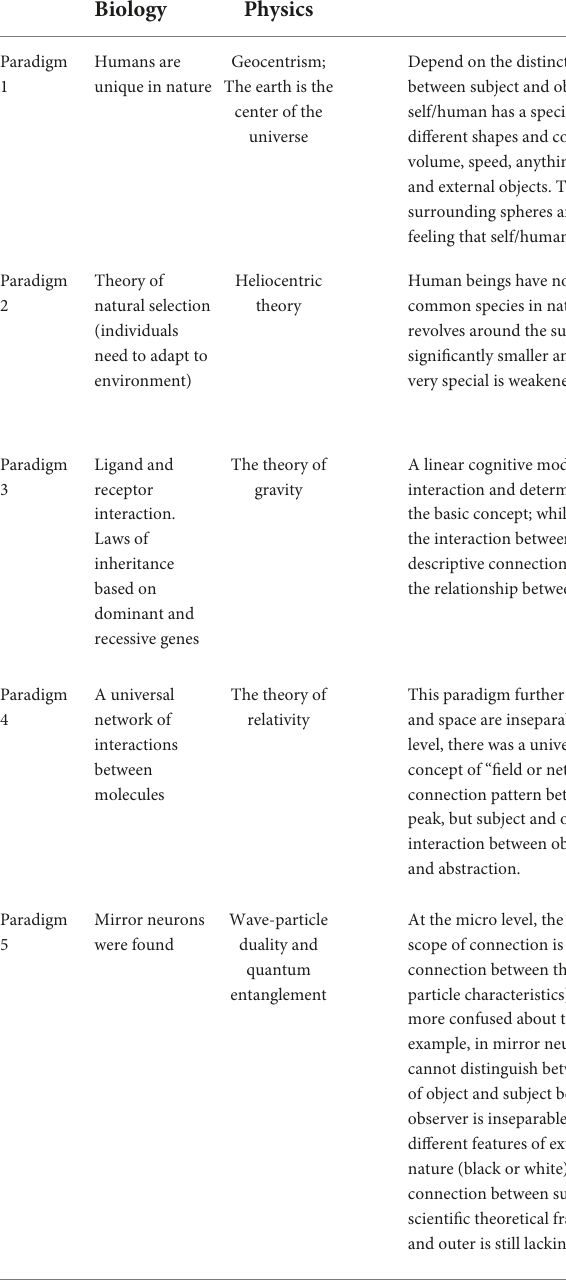
Diagrams used to represent the state of perception abstracted from the phenomena and its evolution